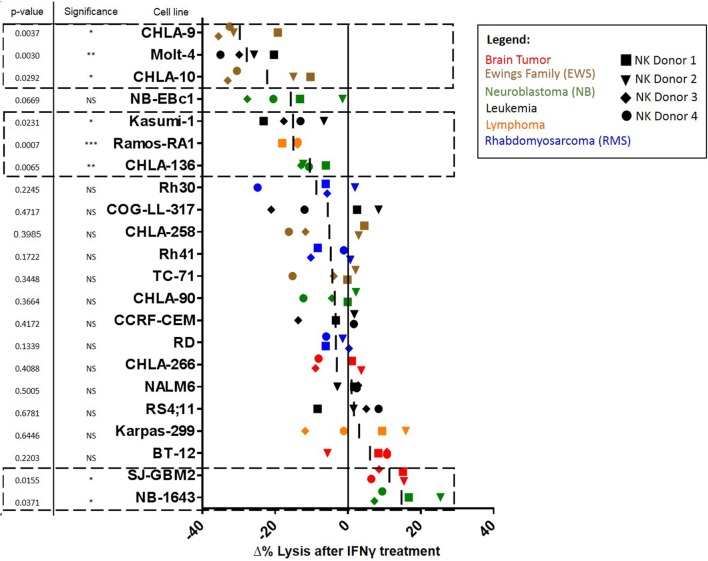
Waterfall plot of change in lysis by natural killer (NK) cells after treatment of pediatric cancer cell lines with IFNγ. NK cell cytotoxic activity toward IFNγ-treated and -untreated cancer cells was evaluated using calcein release assays. Changes in lysis (Δ% Lysis) of treated compared to untreated cancer cells were quantified for each NK cell donor. Each shape represents a different NK cell donor (the same four donors were used for all cell lines). Color coding corresponds to cell line cancer type. p-Values are for probability that Δ% ≠ 0 (t-test). Squares with dashed lines indicate cancer cell lines with significant (p ≤ 0.05) changes in NK cell-mediated lysis after IFNγ treatment.